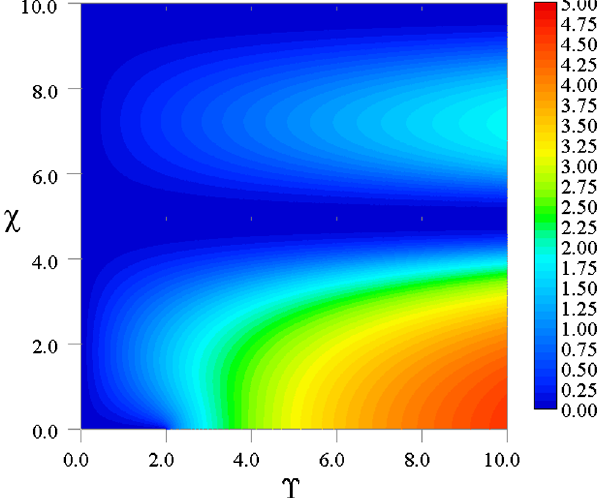
FIG. 8. Flat contour plot in the square well model for the growth factor g × T as a function of ϒ and χ for positive χ : s